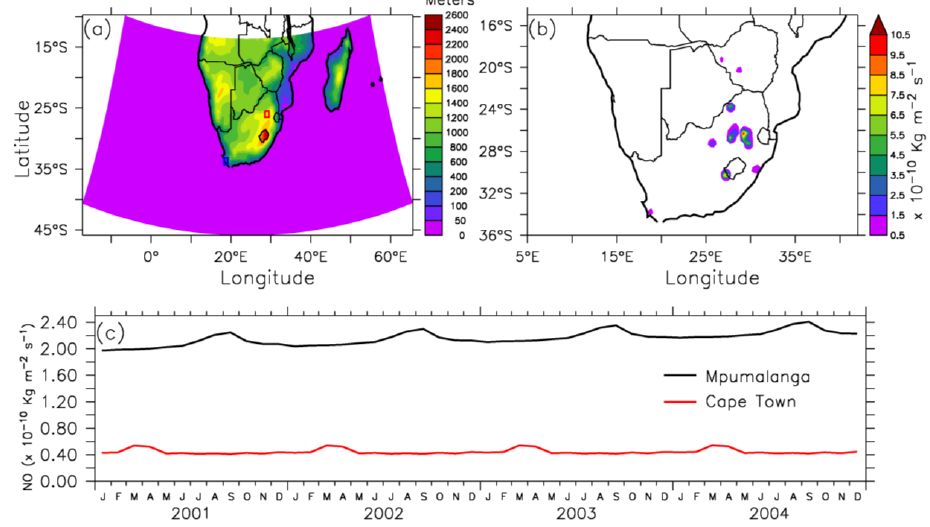
Figure 3: (a) RegCM simulation domain indicating the topography (in meters) of southern Africa Fig. 3. (a) RegCM simulation domain indicating the topography (in metres) of southern Africa as seen by the model; (b) the annual mean as seen by the model; (b) the annual mean of NO emission over South Africa used in the model; of NO emission over South Africa used in the model; (c) the temporal variation of NO emission over Mpumalanga and Cape Town in (c) the temporal variation of NO emission over Mpumalanga and Cape Town in 2001 - 2004. 2001–2004.